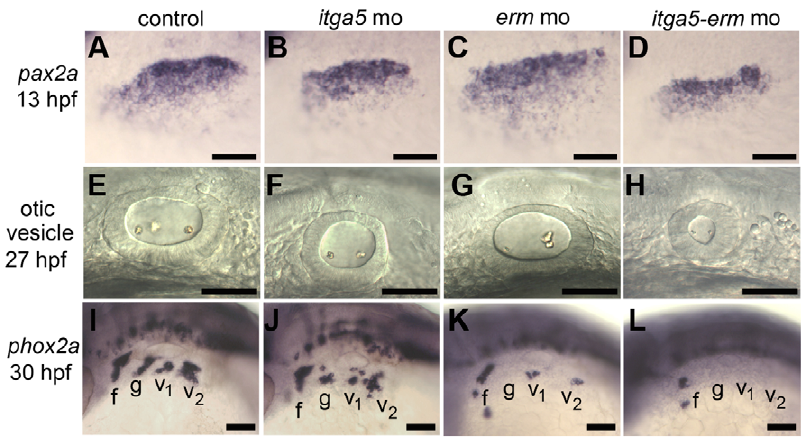
Figure 8. itga5 and erm interact during otic and epibranchial development. ( A–D ) Otic/epibranchial expression of pax2a at 13 hpf. (E–H ) Otic vesicle morphology in at 27 hpf. ( I–L ) phox2a expression in epibranchial ganglia at 30 hpf. Positions of facial (f), glossopharyngeal (g) and vagal (v1 and v2) ganglia are indicated. All images show lateral views with dorsal up and anterior to the left. Scale bar, 50 m m.